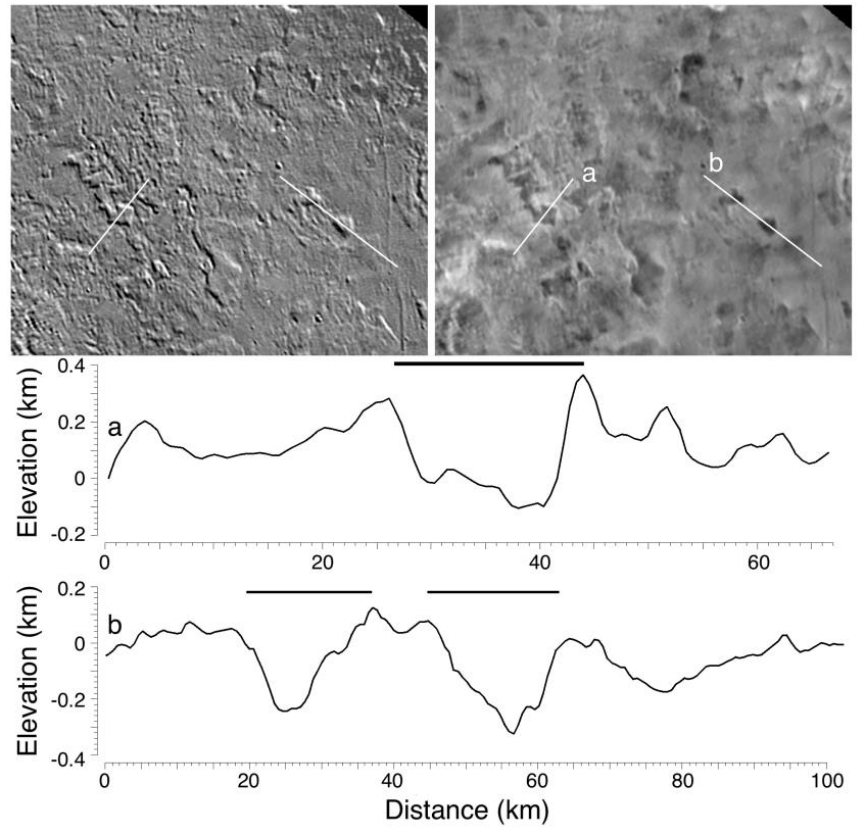
Figure 21. Topographic profiles across closed oval and sigmoidal troughs in the etched plains of Triton. ( Top ) Image mosaic and ( right ) DEM scene width is ~300 km and is centered at 15 ◦ N, 51 ◦ E, from SG-PC-DEM in Figure